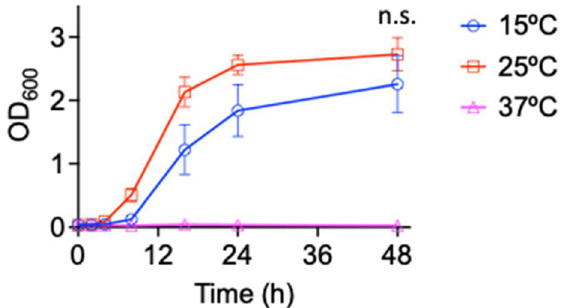
Figure 1. Pseudomonas sp. B14-6 is a psychrotolerant bacterium. Pseudomonas sp. B14-6 was grown at different temperature for 48 h. Bacterial growth was evaluated by absorbance measurement at 600 nm using a plate reader. Doubling times at 15 °C and 25 °C were 2.5 h and 1.7 h, respectively. Results are shown as mean ± SD; n = 3. OD600 between at 15 °C and 25 °C after 48-h incubation showed no significant difference (n.s. p > 0.05, t -test). Table 1. Minimum inhibitory concentration (µg/mL) at different temperature.